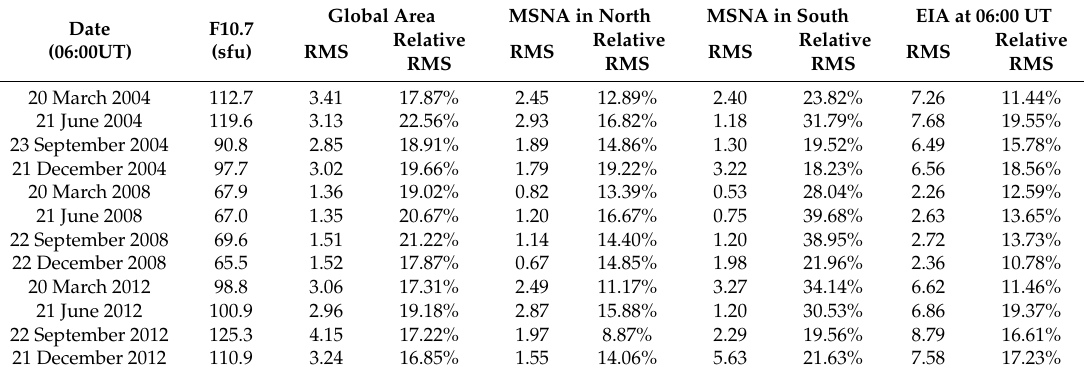
Figure 7. Comparison of CODE GIMs and TECM-GRID models (2012). Table 1. RMS and relative RMS statistics of difference between CODE GIM and TECM-GRID.